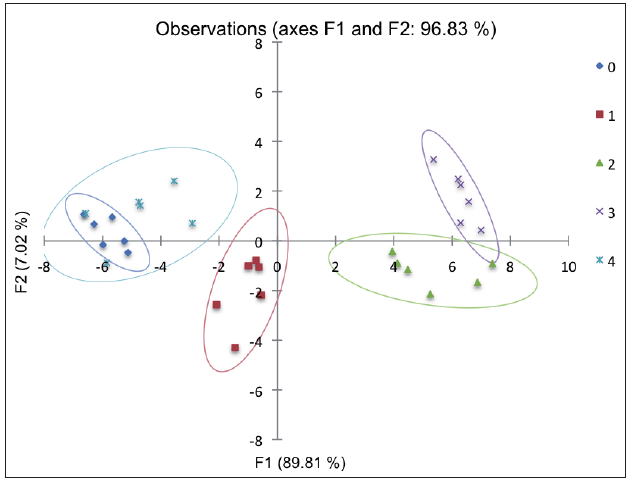
Fig. 6: Discriminant analysis (DA) observations chart of ‘Granny Smith’ apples with different scald severity: 0, no scald; 1, 1-25%; 2, 26- 50%; 3, 51-75%; 4, 76-100%.